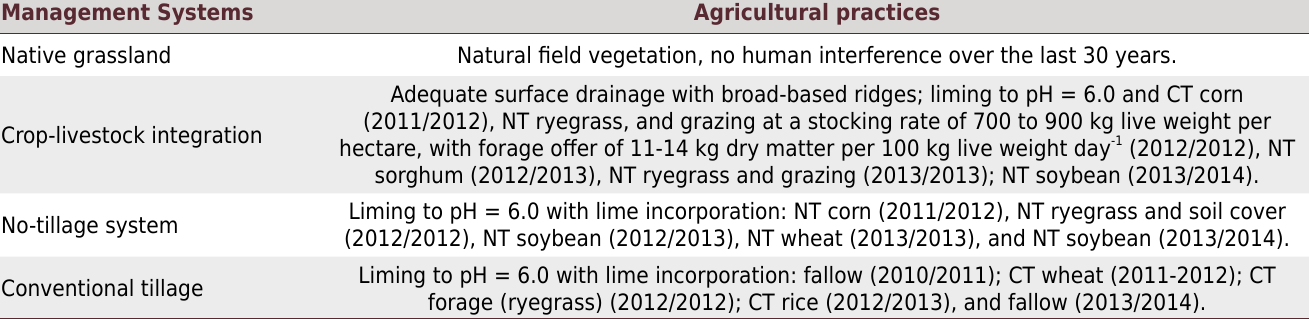
Table 1. Agricultural practices applied under different management systems, on a typic eutrophic Albaqualf - Planossolo háplico eutrófico in the south of Brazil Management Systems Agricultural practices Native grassland